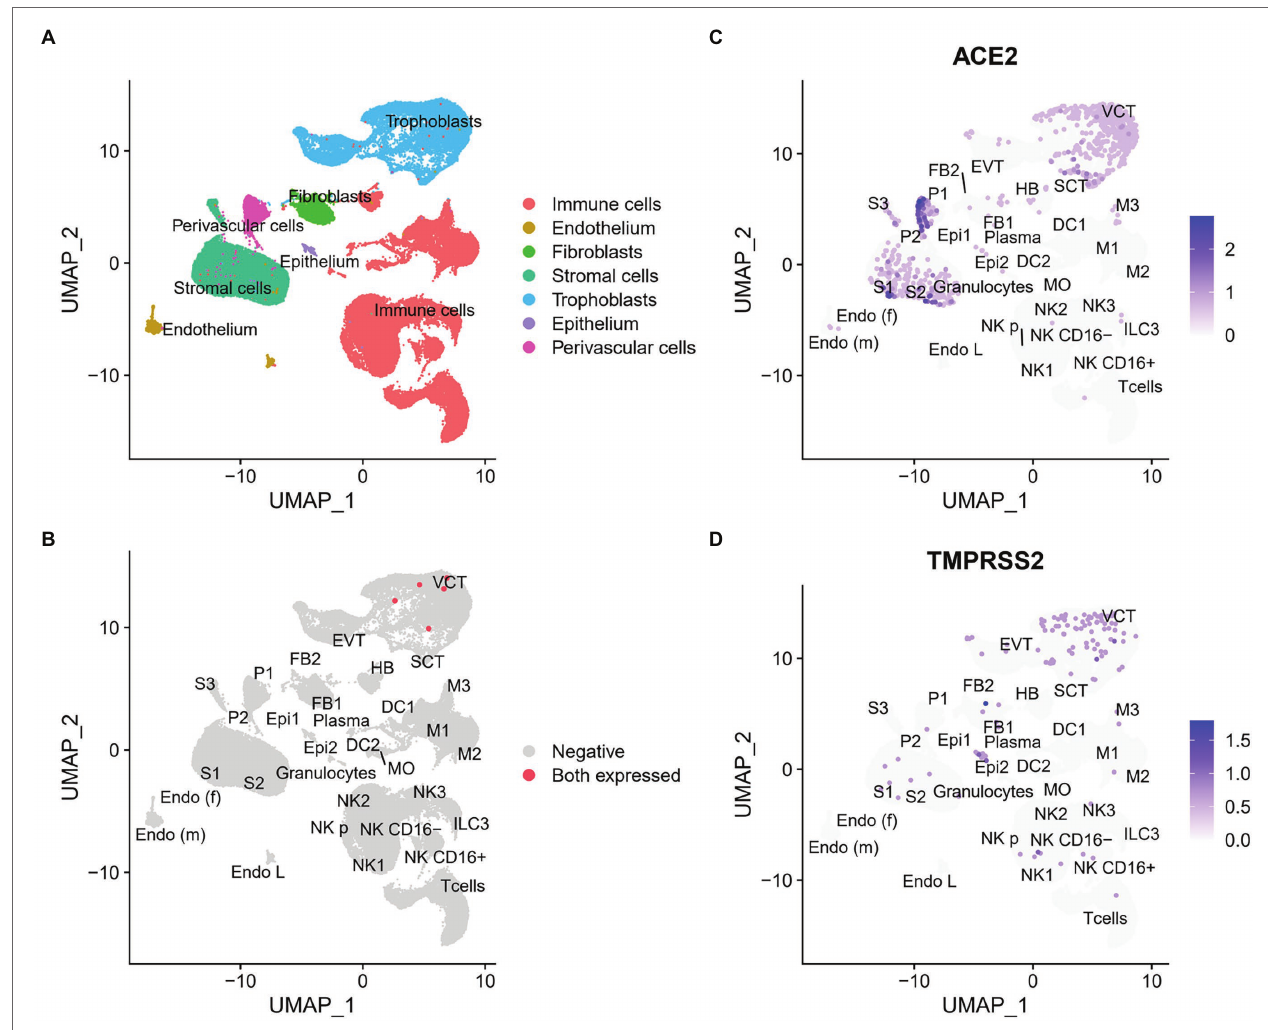
FIGURE 3 | Identification and expression of cell types at the maternal–fetal interface. (A) The UMAP clusters plot of cell types at the maternal–fetal interface using scRNA-seq analysis, dots means a single cell and colors indicate cell type {epithelium (Epi1, Epi2), endothelium [Endo L, Endo (f), Endo (m)], stromal cells (S1, S2, S3), perivascular cells (P1, P2), fibroblasts (FB1, FB2), trophoblast (VCT, SCT, EVT), and immune cells (HB, DC1, DC2, MO, NK CD16 − , NK CD16+, T cells, granulocytes, M1, M2, M3, NKp, NK1, NK2, NK3, ILC3, and plasma)}. DC, dendritic cells; M, macrophages; MO, monocytes; S, stromal cells; Endo, endothelial cells; Epi, epithelial glandular cells; FB, fibroblasts; HB, Hofbauer cells; P, perivascular cells; ILC, innate lymphocyte cells; SCT, syncytiotrophoblast; VCT, villous cytotrophoblast; EVT, extravillous trophoblast. And the points in (B) colored red are the cells co-expressed ACE2 and TMPRSS2. UMAP visualization of the log- transformed, normalized expression of ACE2 (C) , and TMPRSS2 (D) at the maternal–fetal interface using scRNA-seq analysis, dots mean a single cell and colors indicate different expression